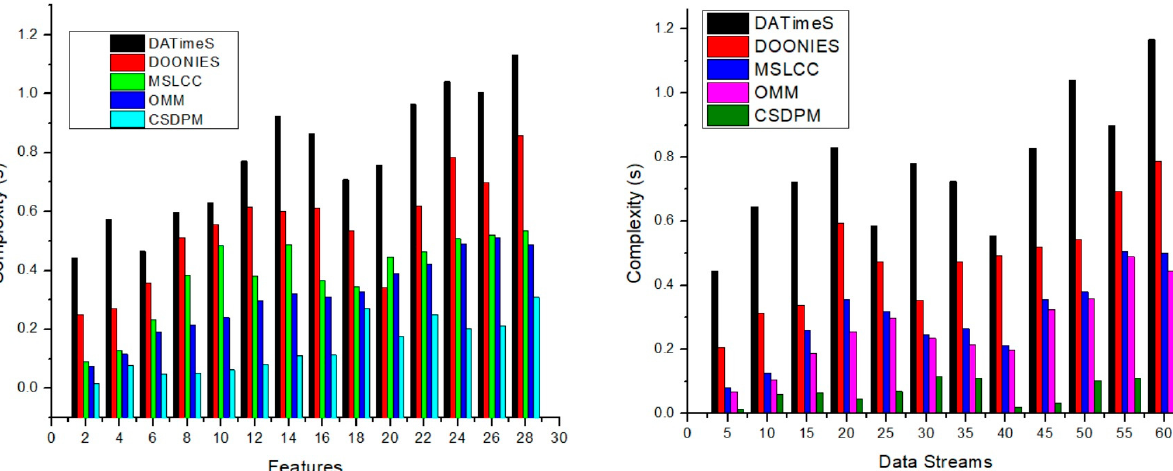
Figure 14. Complexity. Figure 14.